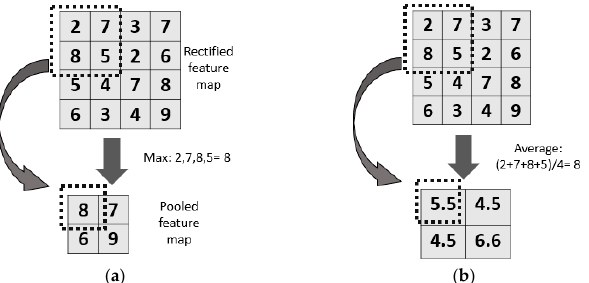
Figure 9. Example of pooling operation: ( a ) maximum pooling, ( b ) average